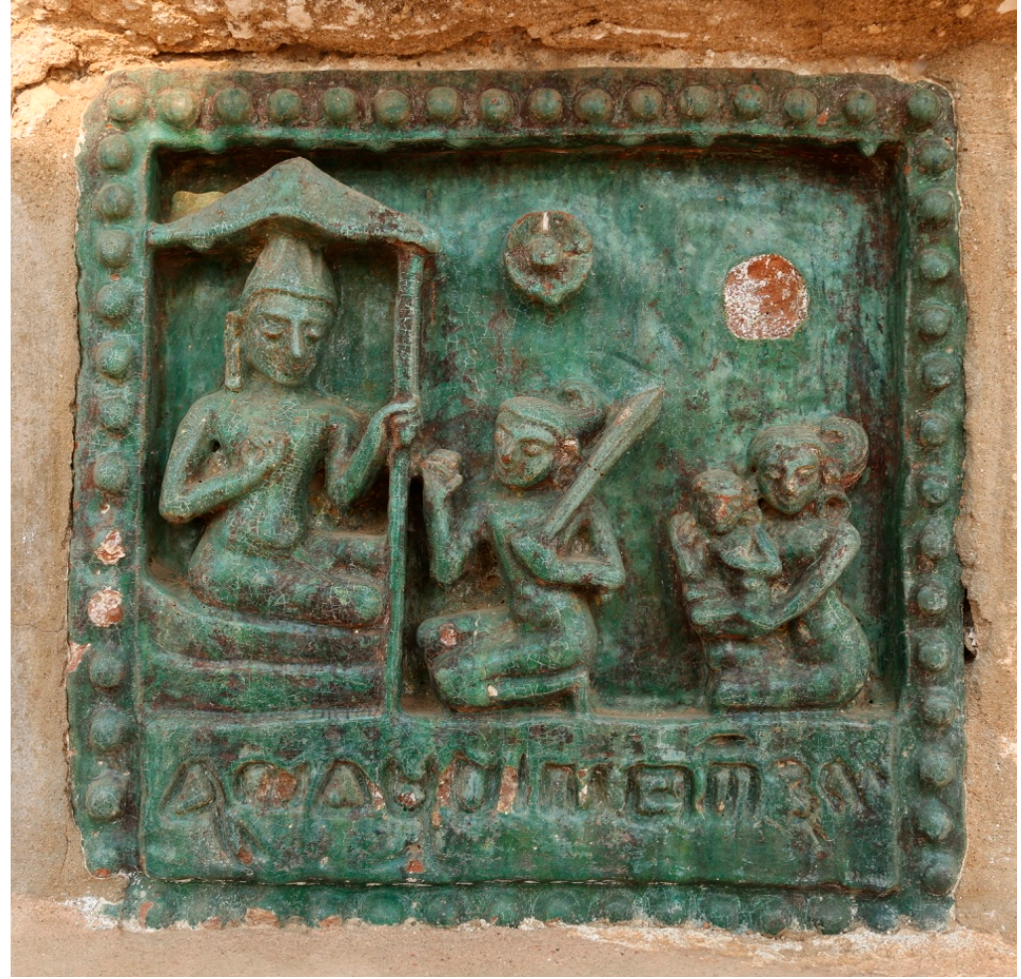
Figure 20. Pagan, Ananda 11th century. C ū ḷ adhammap ā la J ā taka, 358—the bodhisatta’s mother is cradling the baby prior to its dismemberment.